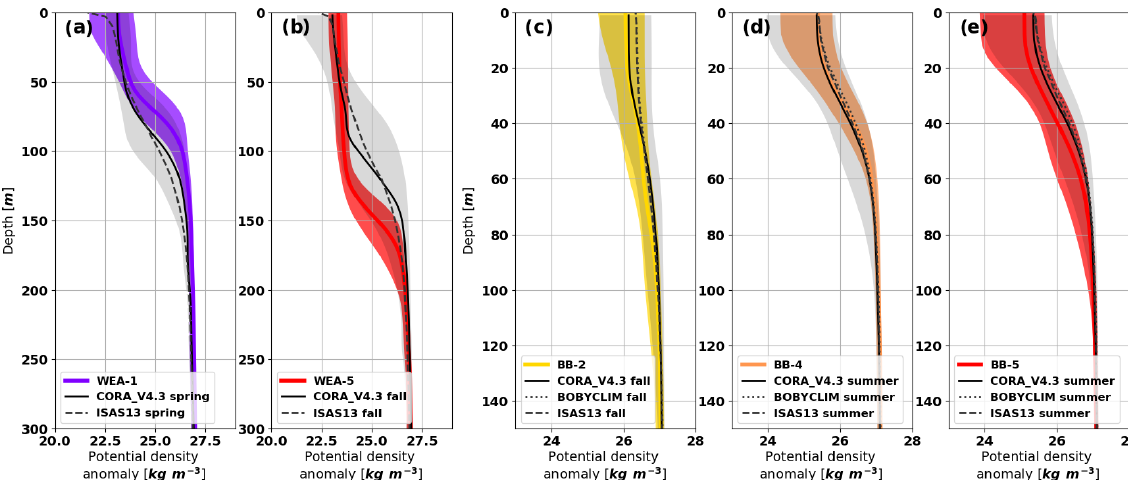
Figure 4. Climatology profiles compared with the corresponding selected typical profiles from the cluster classification: the western equato- rial Atlantic (a) WEA-1 and (b) WEA-3 and the Bay of Biscay (c) BB-1, (d) BB-4 and (e) BB-5. The gray shadings are the 90% interval calculated from the CORA V4.3 dataset using seasonal classification, and the colored shadings are the 90% interval of each